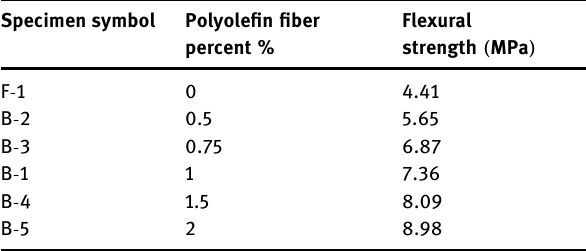
Table 10: E ff ect of polyole fi n fi ber on fl exural strength of concrete Specimen symbol